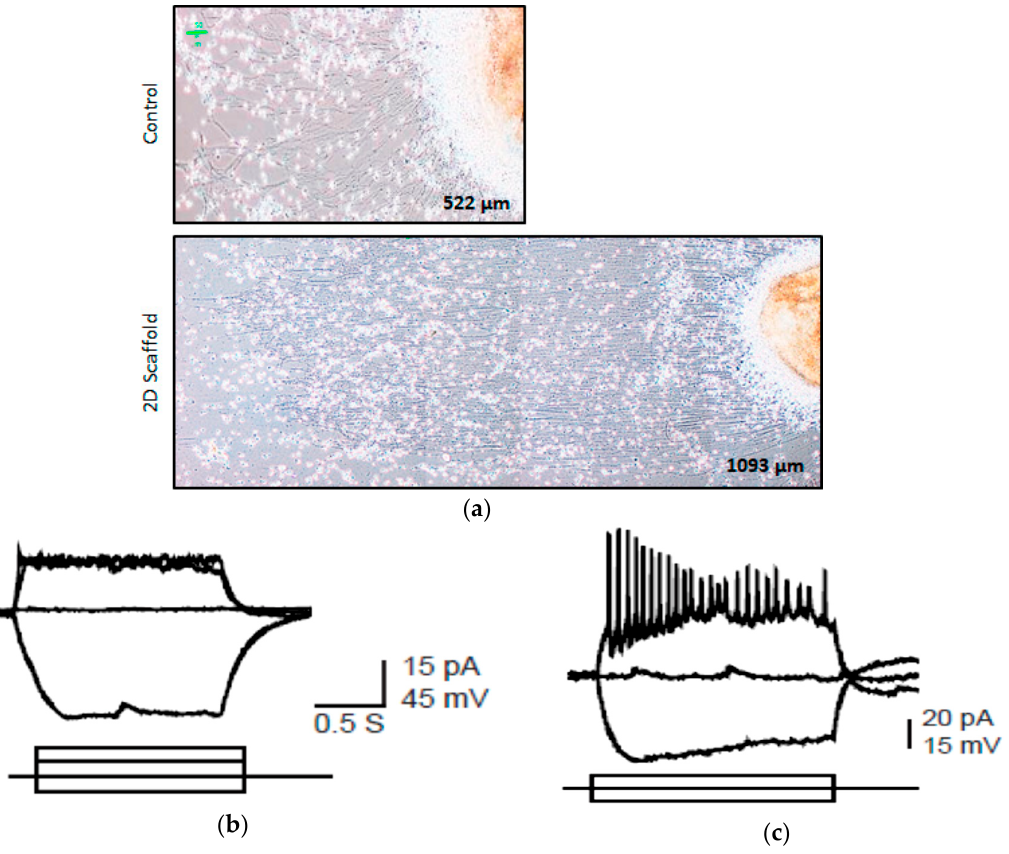
Figure 5. Neurite outgrowth of clinical patient derived OV on the 2D scaffold. Human iPSCs from patient with clinical optic nerve degenerative disease are differentiated into OVs and seed on two-dimensional scaffolds. ( a ) The patient cell’s neurite outgrowth on two-dimensional scaffold (button panel) and without two-dimensional scaffold (top panel). The length of the RGC nerve bundle without the scaffold is about 522 ± 32 µm. The length of the RGC nerve bundle with a 2D scaffold is about 1093 ± 53 µm, which is significantly longer ( p < 0.01); ( b ) the RGC of the patient without the scaffold shows an action potential; ( c ) the patient’s RGC on the 2D scaffold shows a repetitive action potential in response to the continuous current injection.